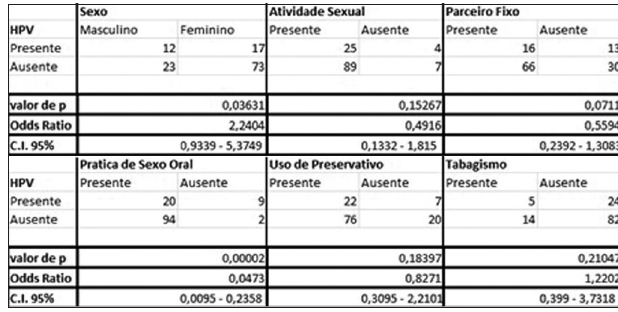
Figura 1. Teste Exato de Fischer (Relação estatisticamente significante se p < 0,05). Dentre os indivíduos abordados pela pesquisa,